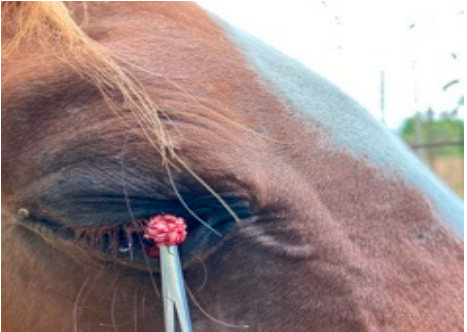
Figure 2. Acuminate, horny fronds at the inner surface of the conjunctival mass after surgery. The nodule did not invade the cornea and was approximately 2 cm in diameter. After cline hydrochloride (Ophtocycline, Dechra Veterinary Products S.r.l., Torino, Italy),